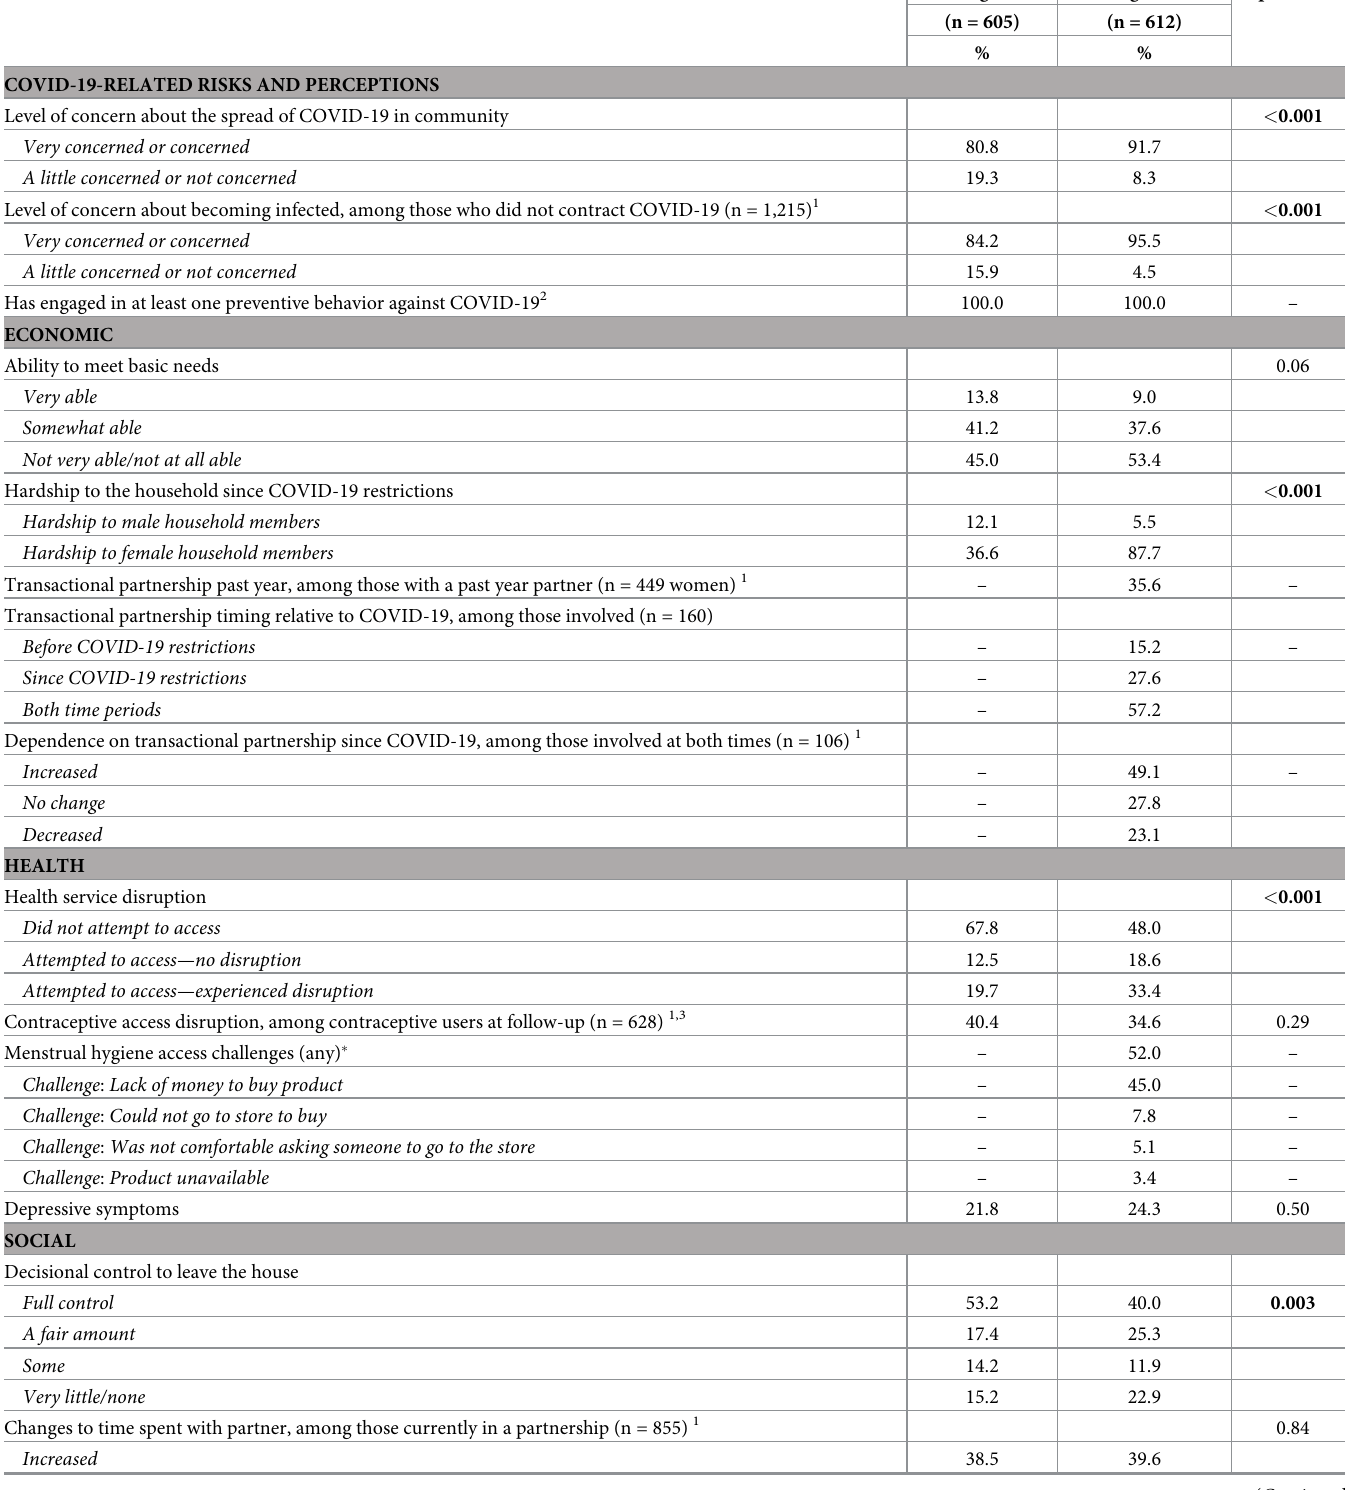
Table 2. Key health, economic, social, and safety indicators among Nairobi youth and young adults in August-October 2020; by gender, weighted (n =